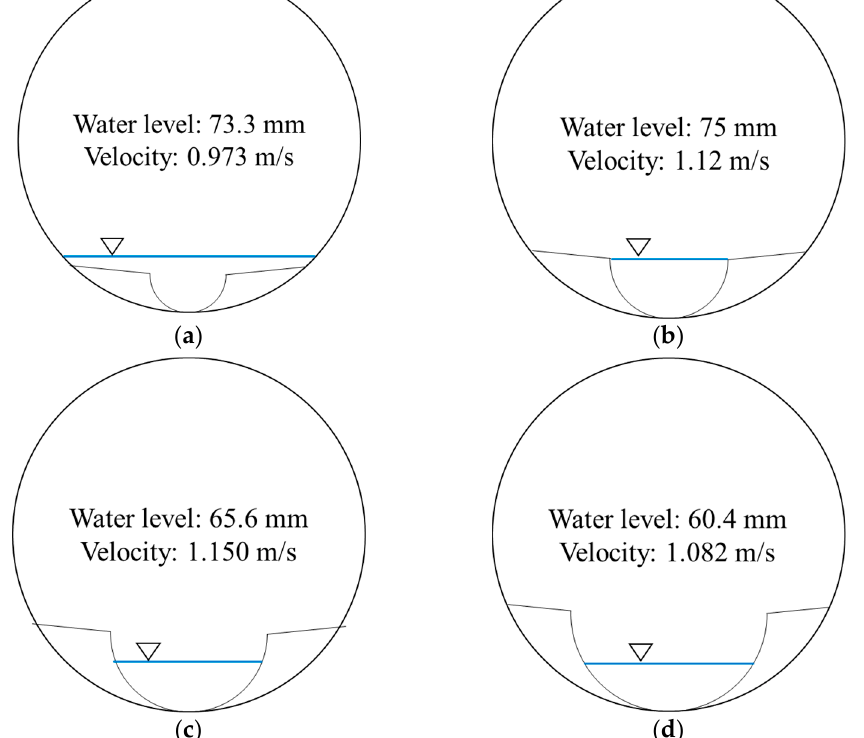
Figure 5. Changes in flow with the sub-pipe of 100 ( a ), 150 ( b ), 200 ( c ), and 250 mm ( d ) diameter in a 450 mm diameter main pipe ( Q = 9.899 L/s, n = 0.01 s/m 1/3 , S = 0.01).